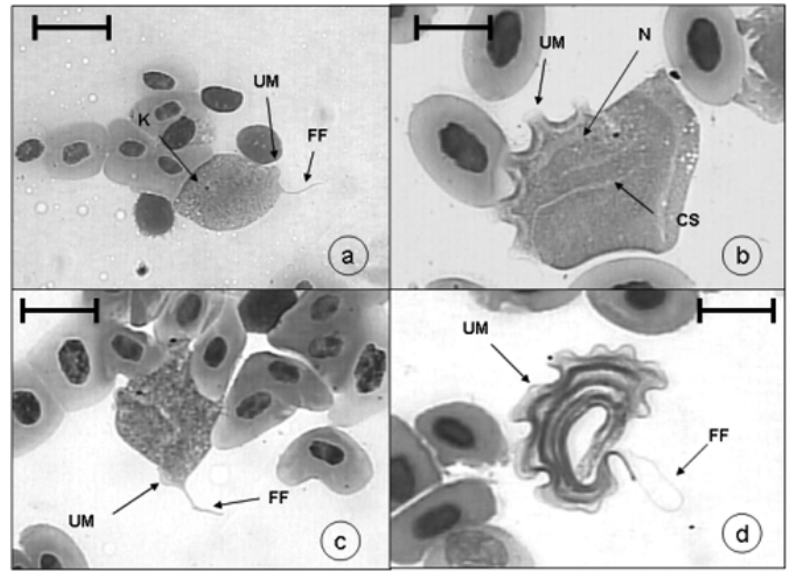
Fig. 3 – Hemogregarine morphometrical parameters observed in four species of anurans captured in São Paulo and Mato Grosso do Sul States – Brazil.